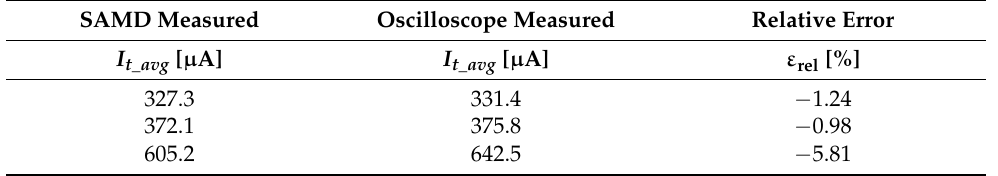
Table 5. Experimental results’